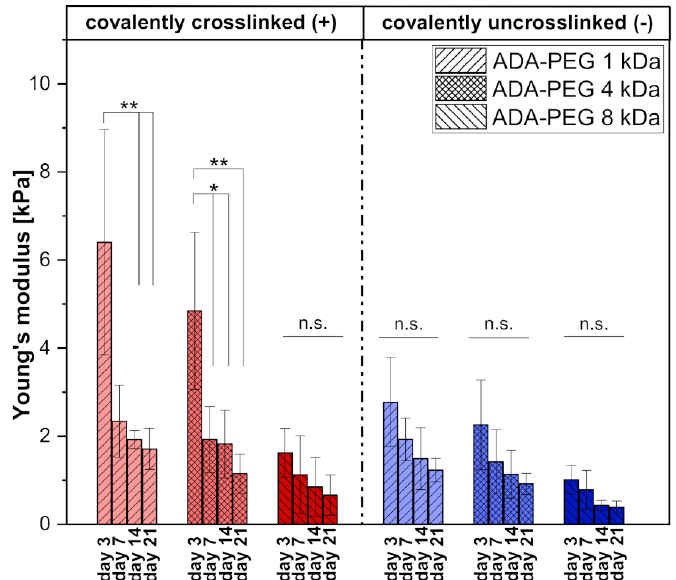
Figure 5. Mechanical analysis of ADA-PEG inks after crosslinking with CaCl 2 . Compression stress studies revealing Young’s moduli of crosslinked (+) and uncrosslinked (-) ADA-PEG inks over an incubation time of 21 days incubated at 37 ◦ C in a controlled atmosphere of 5% CO 2 and 95% relative humidity. All data is displayed as SD. ns * p < 0.05, ** p < 0.01, *** p < 0.001.